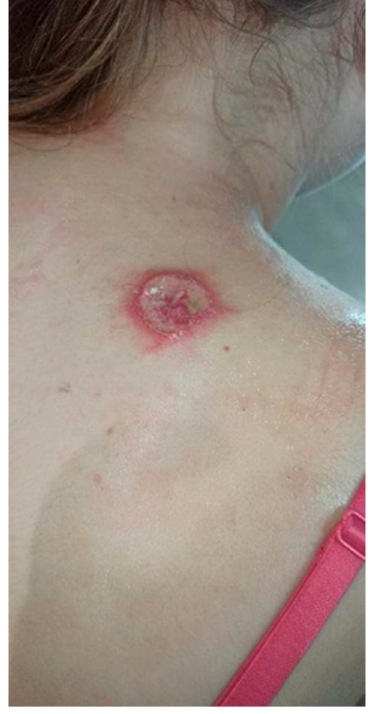
Figure 3. Ulceration with an active edge.